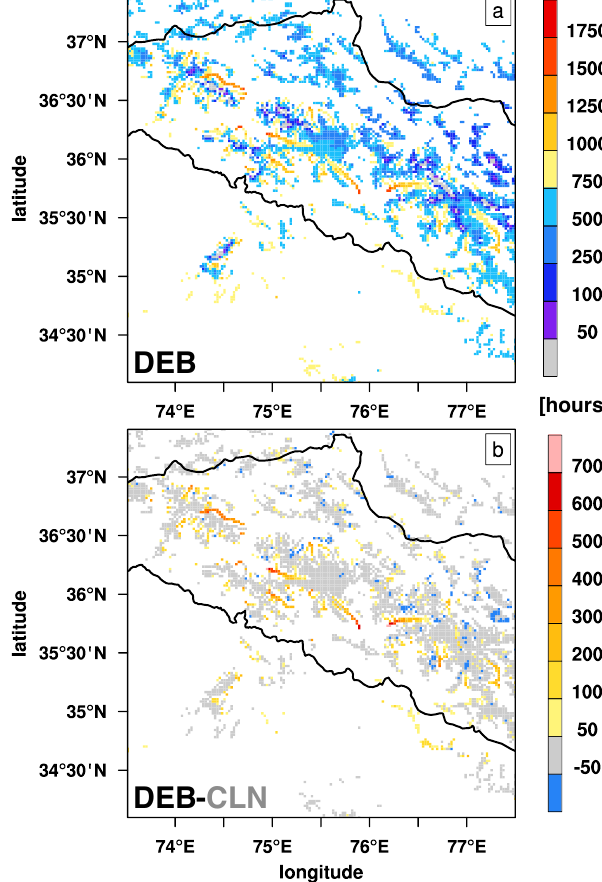
Figure 8. Cumulative CMB in [kgm − 2 ] between 1 July and 15 September 2004 for (a) the DEB simulation and (b) the difference between DEB and CLN. The black contour delineates the region where centerline information was available from Rankl et al. (2014).